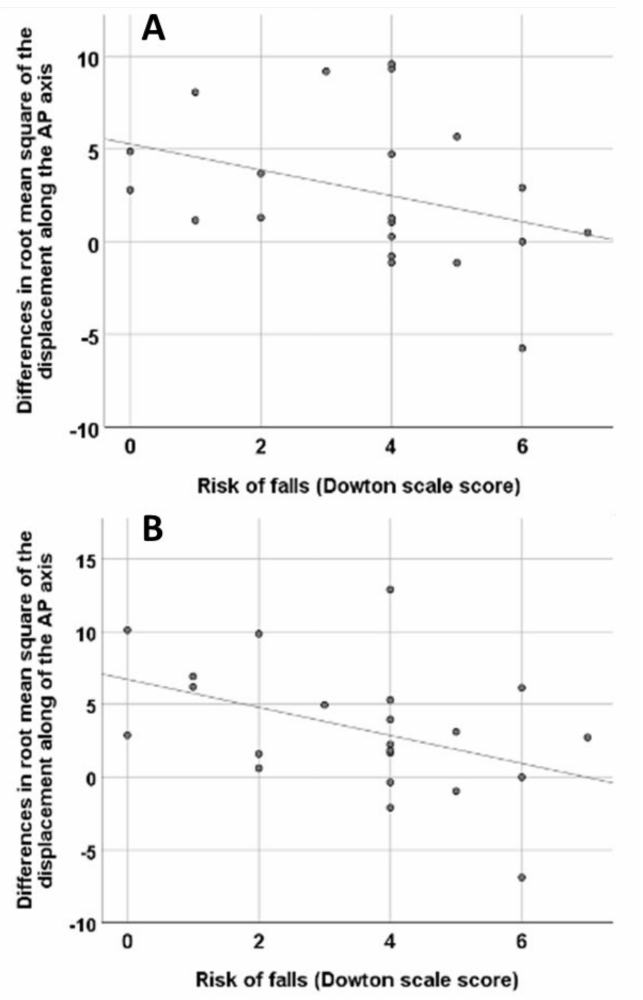
Figure 2. ( A ): Correlation between the differences between the T1 (after 30 min wearing the insoles) and T0 (baseline) tandem root mean square of displacement on the AP axis ( p = 0.048, Spearman correlation), and the Downton scale. ( B ): Correlation between the differences between the T2 (after one week wearing the insoles) and T0 tandem root mean square of displacement on the AP axis ( p = 0.047, Spearman correlation) and the Downton scale